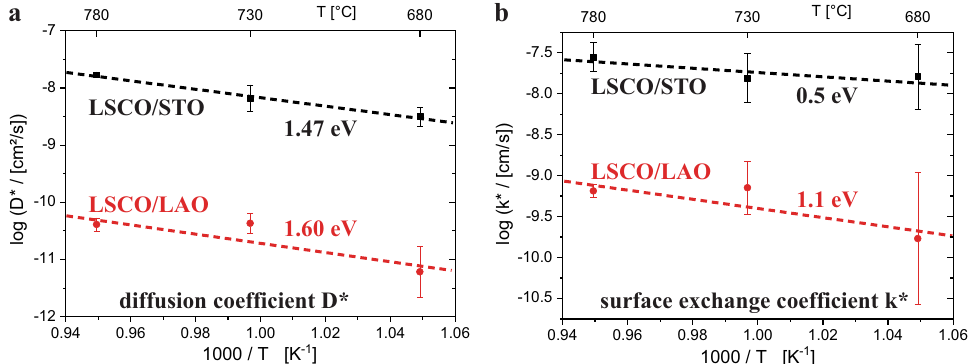
Fig. 4 The results of the in-plane isotope exchange measurements. Evaluation of the tracer surface exchange parameter k * ( a ) and the tracer diffusion coef fi cient D * ( b ) for three different temperatures, 680, 730, and 780 °C. Error bars were calculated from at least four individual 1D diffusion pro fi les measured for each temperature and substrate. The respective fi tting curves and activation energies are plotted, assuming Arrhenius-type behavior. The error bars show the standard deviation for the